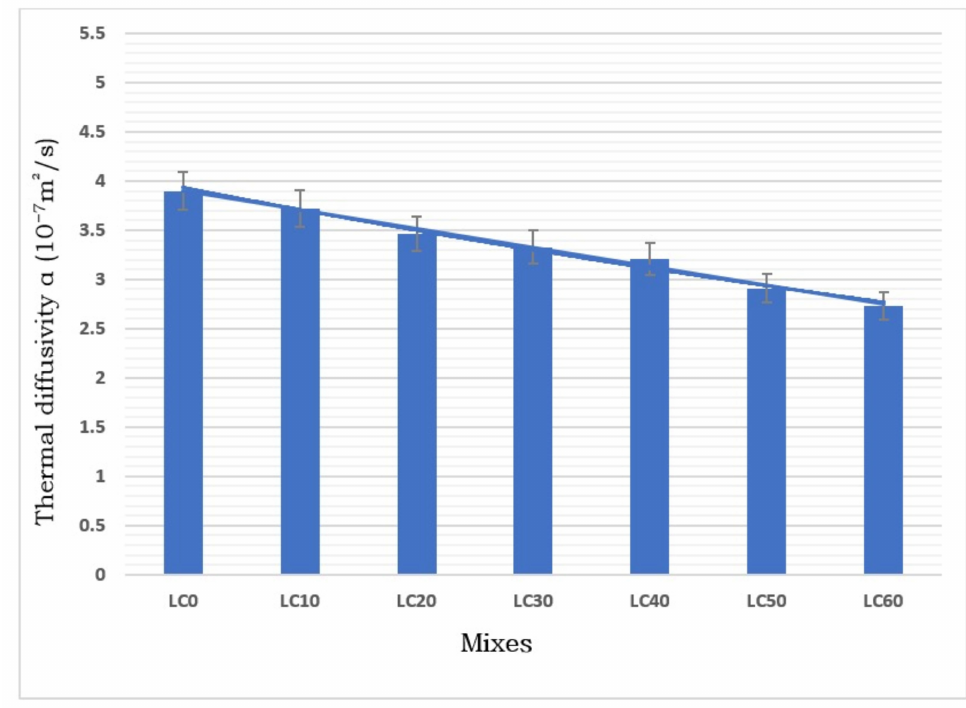
Figure 9. Effect of EPA aggregate dosage on the thermal diffusivity of concrete